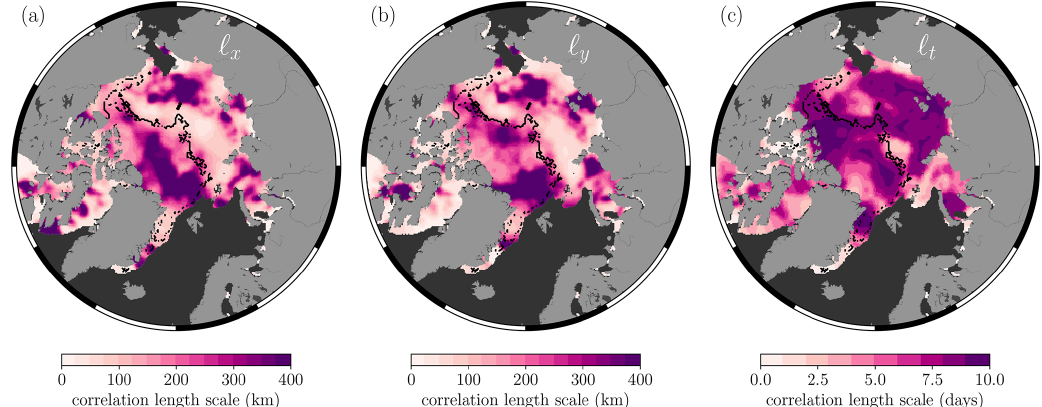
Figure 4. The 25 × 25km gridded (a) zonal, (b) meridional, and (c) temporal correlation length scales which maximise the log marginal likelihood function (Eq. 4) for the 1 December 2018. The black contour also corresponds to the FYI/MYI contour for the 1 December 2018.